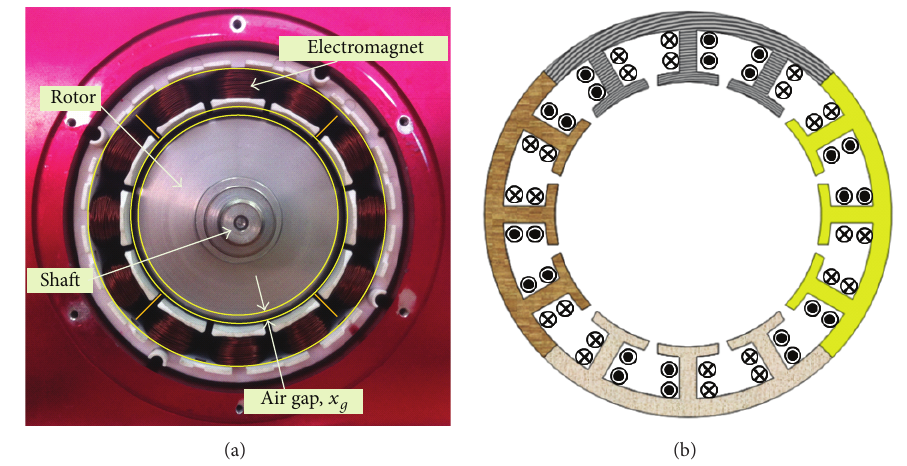
Figure 13: Inside view (a) and layout (b) of magnetic bearing.